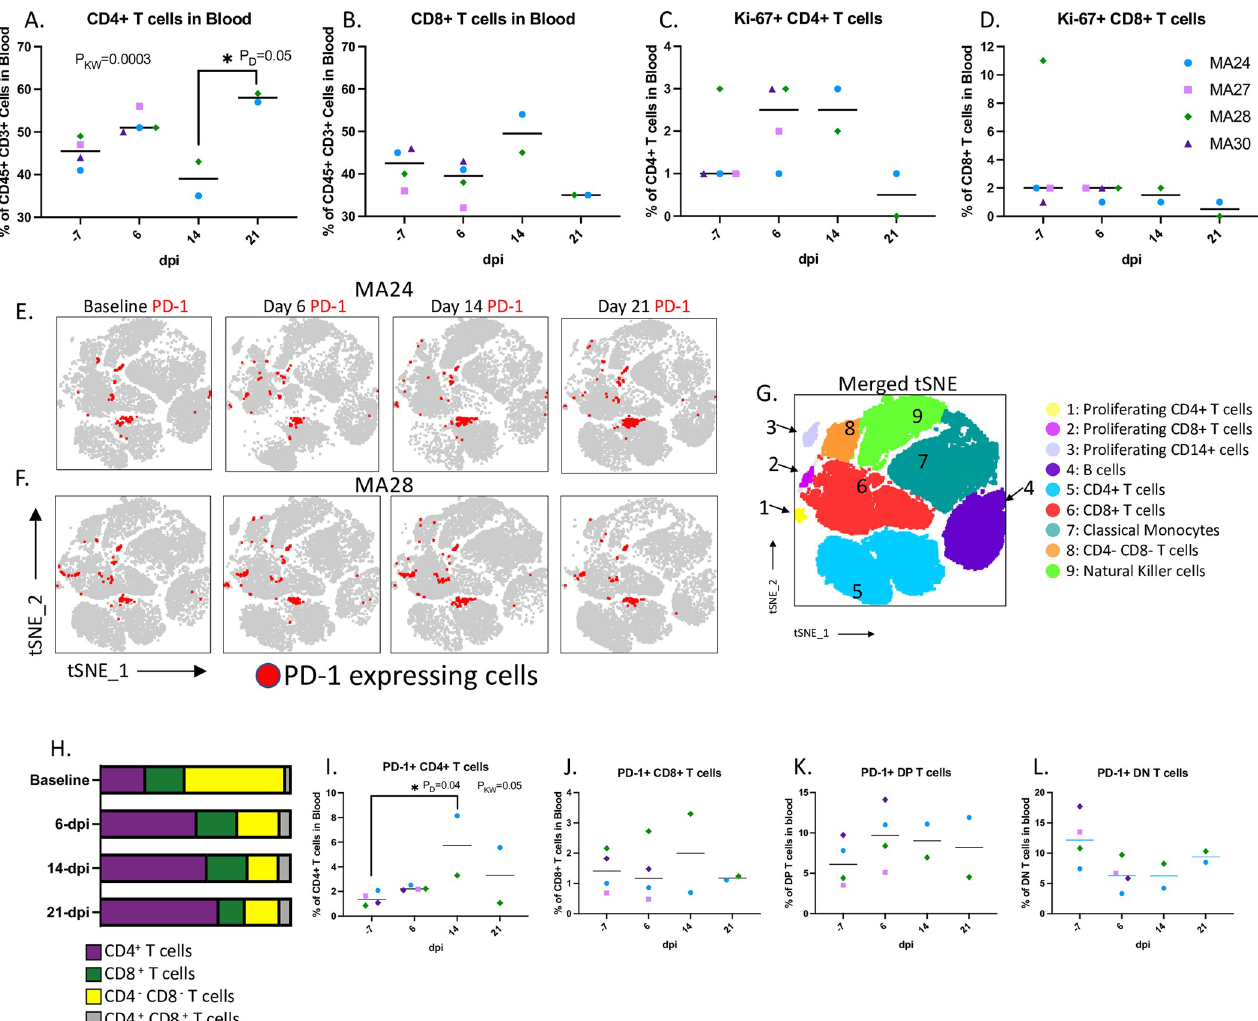
Fig 6. T cells in the blood. A-B. CD4+ (A) and CD8+ (B) T cell frequencies in the blood before and 6-, 14-, and 21-days post SARS-CoV-2 infection. C-D. Changes in Ki-67 expressing CD4+ (C) and CD8+ (D) T cells. Bars represent median E. tSNE plots displaying changes in PD-1 expression (red) in peripheral CD45+ cells overtime. MA24 (E) and MA28 (F) displayed as representative animals. G. Merged tSNE indicating phenotype of the tSNE defined cell populations in E and F. H. Average changes in the percentages of CD4+, CD8+, CD4- CD8- (DN) and CD4+ CD8+ (DP) T cells within the total PD-1+ CD3 + cell population. I-L. Frequency of PD-1+ expressing CD4+ (I), CD8+ (J), DP (K) and DN (L) T cells in the blood. Bars represent median. Kruskal-Wallis comparison of overall means (P KW ) and Dunn’s Multiple comparisons (designated by line, P D ) tests used to determine significance. P values � 0.05 reported. Baseline (-7): n = 4, Day 6: n = 4, Day 14: n = 2, Day 21: n =